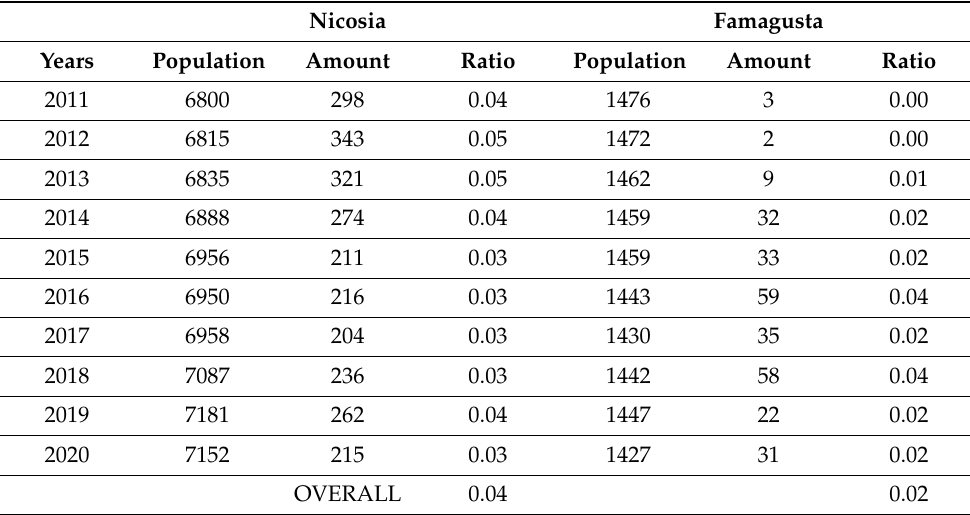
Table 2. Crime Analysis in Nicosia and Famagusta Walled